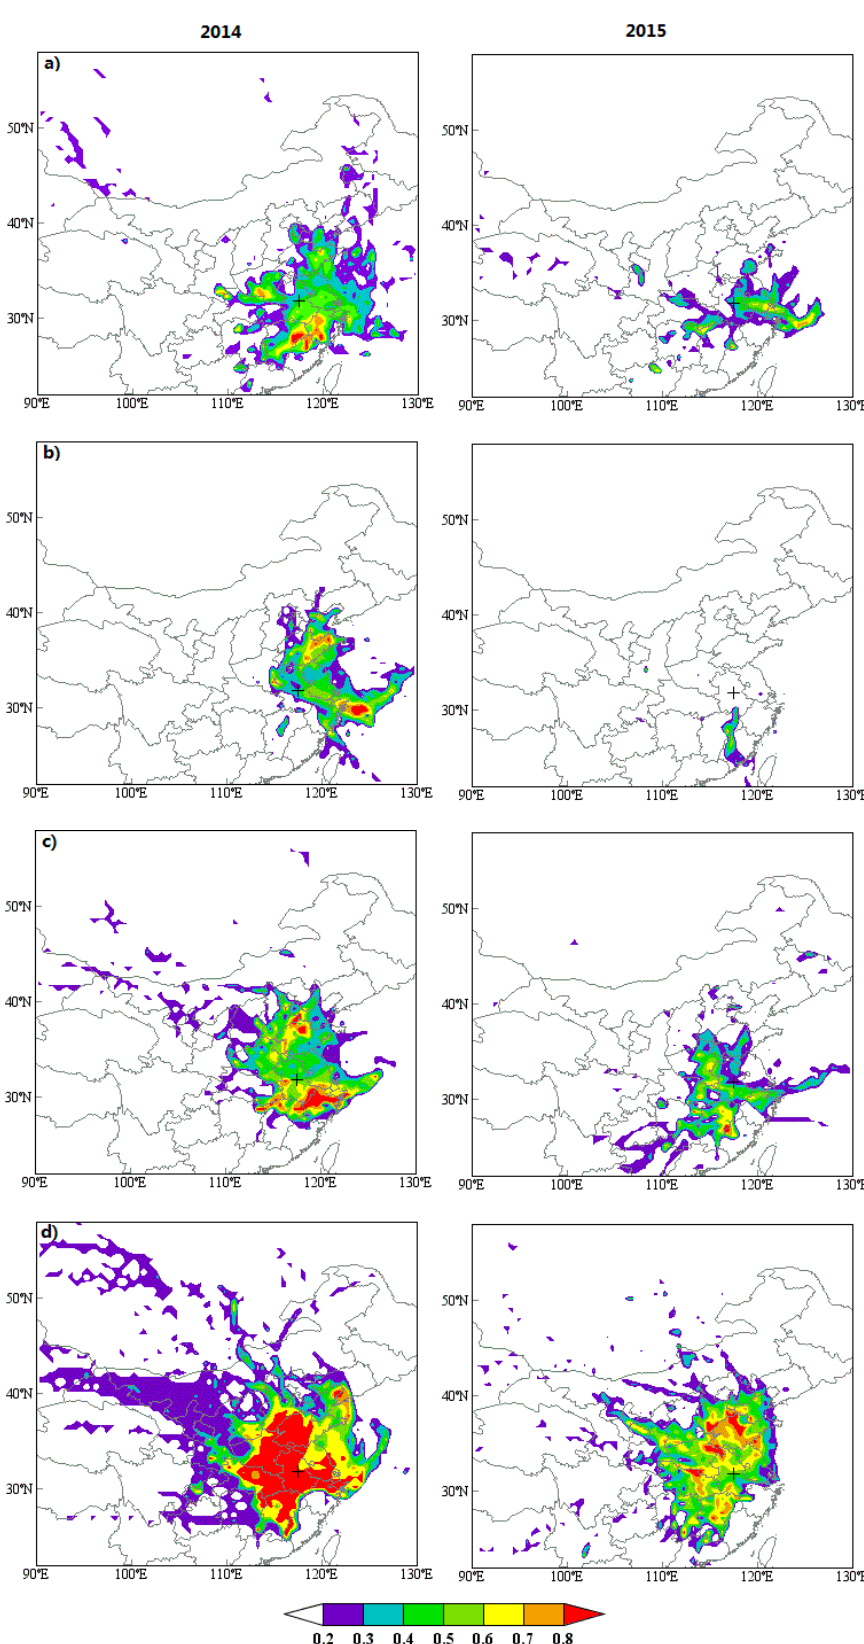
Figure 7. Seasonal potential source contribution function (PSCF) maps for PM 2.5 at Hefei in 2014 and 2015: ( a ) spring, ( b ) summer, ( c ) autumn, ( d ) winter. The center of Hefei is marked by the cross and the PSCF values are displayed in color.